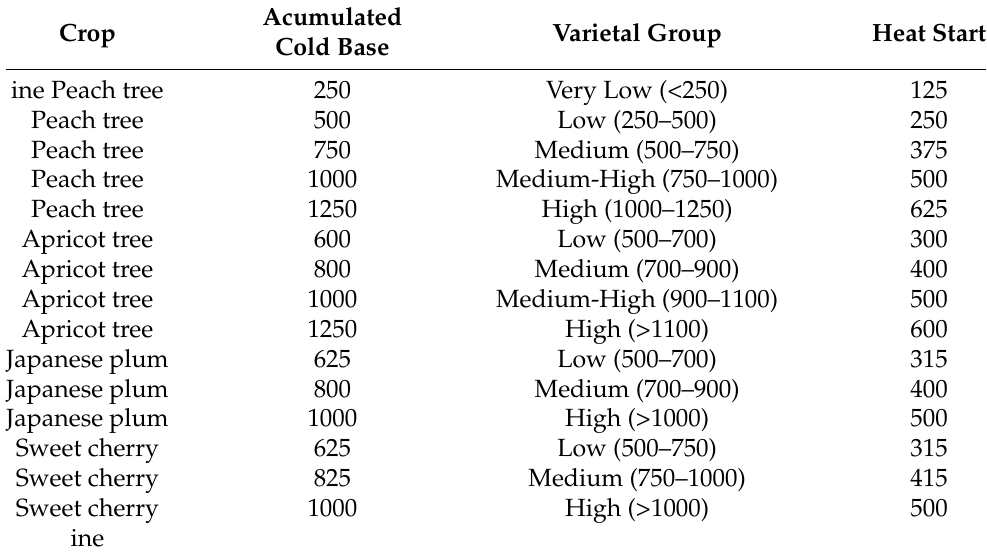
Table 2. Quantification of chilling unit requirements for varietal groups of different stone fruit trees. Crop